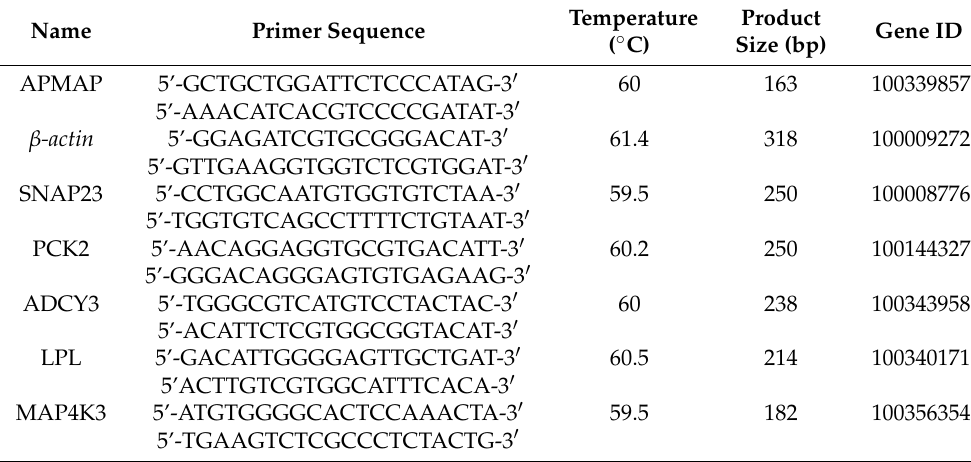
Table 1. Primer pairs used for